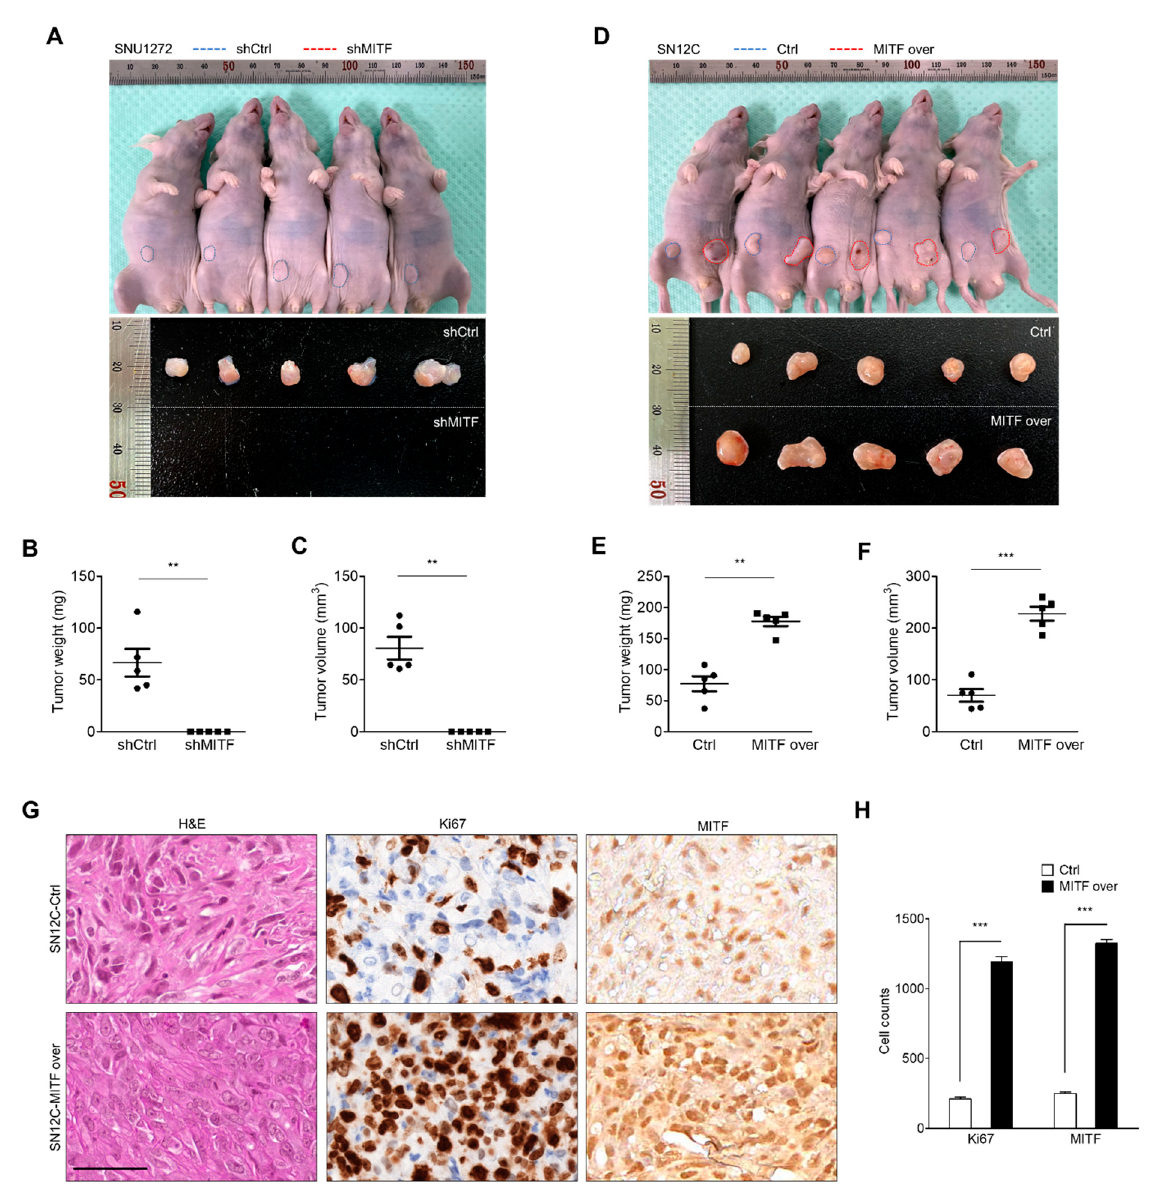
Figure 6. MITF affects tumorigenesis in ccRCC in vivo. ( A ) SNU1272-shCtrl and SNU1272-shMITF cells were subcutaneously injected into both flanks of BALB/c nude mice ( n = 5). Upper panel: representative images showing tumor-bearing mice and sizes of tumors injected with SNU1272-shCtrl and SNU1272-shMITF cells at 60 days. Lower panel: representative images of the removed tumors. ( B , C ) Tumor weight and volume, evaluated after dissecting tumors from the mice in each group. Tumor growth was significantly impaired in the MITF knockdown group. Data are presented as the means ± standard deviation and were evaluated using Student’s t-test ( n = 5). ( D ) SN12C-Ctrl and SN12C-MITF cells were subcutaneously injected into both flanks of BALB/c nude mice ( n = 5). Upper panel: representative images showing tumor-bearing mice and the sizes of the tumors injected with SN12C-Ctrl and SN12C-MITF cells at 34 days. Lower panel: representative images of the removed tumors. ( E , F ) Tumor weight and volume, evaluated after dissecting tumors from the mice in each group. Tumor growth significantly increased in the MITF overexpression group. Data are presented as the means ± standard deviation and were evaluated using Student’s t -test ( n = 5). ( G , H ) Representative images of H&E, Ki-67 and MITF